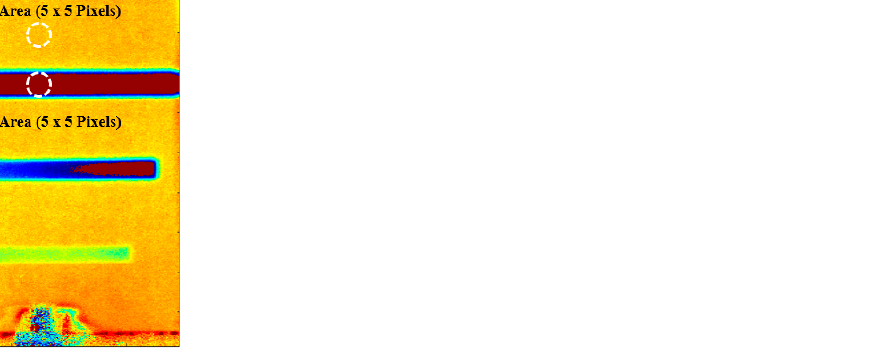
Figure 12. Representation of selected areas for phase contrast and signal to noise ratio (SNR) com- putation.